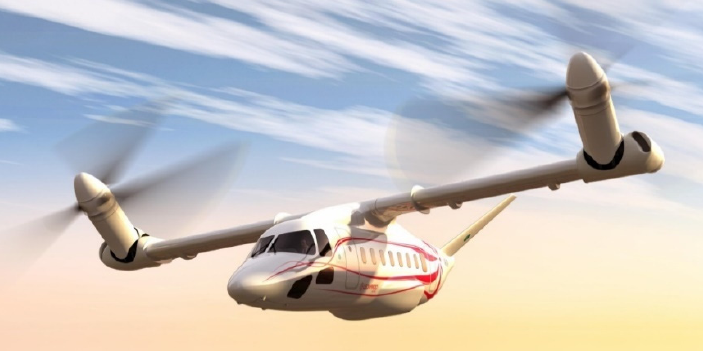
Figure 1. NGCTR tiltrotor, courtesy of Leonardo Helicopters (https://svppbellum.blogspot.com/20 20/01/il-next-generation-civil-tiltrotor.html, accessed on 28 January